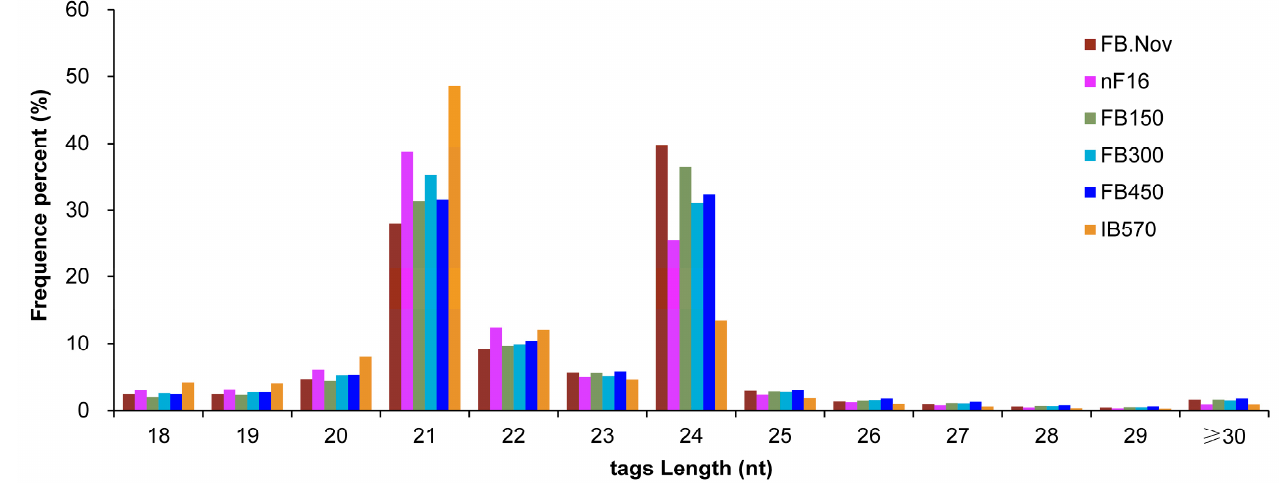
Figure 1. Sequence length distribution of sRNAs in the floral buds of wintersweet. FB.Nov: FBs in November before treatment; nF16: FBs collected after treatment for − 300 CU chilling accumulation at 16 °C; FB150, FB300, FB450, and IB570: FBs collected after treatment for 150, 300, 450, and 570 CU chilling accumulations at 12 °C, respectively.